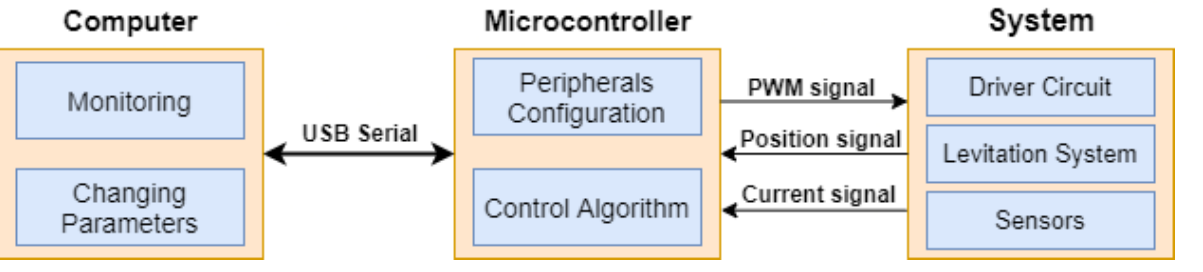
Figure 1. General system architecture.